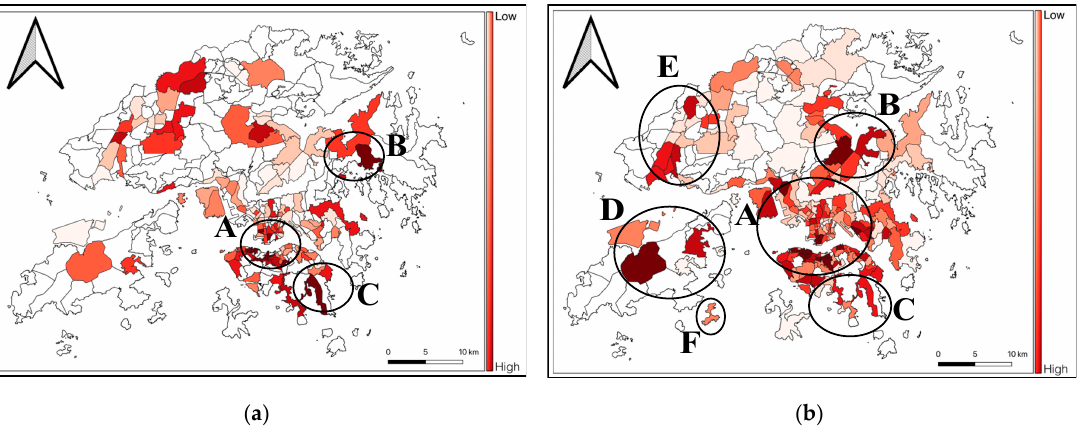
Figure 5. Spatial distribution of COVID-19 risk in Hong Kong: ( a ) Spatial distribution of R1; ( b ) Spatial distribution of R2.